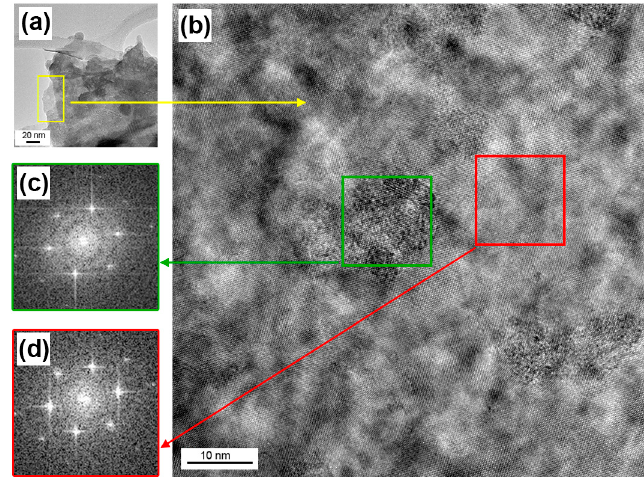
Figure 11. HRTEM images of the WS 2 film pre-annealed at 180 ◦ C. ( b ) Magnification of the yellow area of Figure 11 ( a ) displaying the presence of ordered structures (i.e., inside the red square) referred to crystalline WS 2 and the presence of disordered ones (i.e., inside the green square) attributed to amorphous WO 3 . Related Selected Area Electron Di ff raction (SAED) patterns are shown in ( c ) and ( d ), highlighting the occurrence of sharper reflections ( d ) associated to crystalline WS 2 .